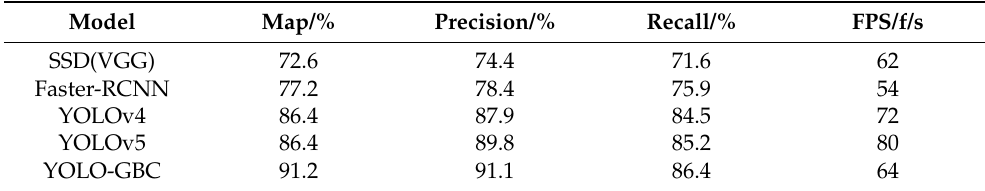
Table 1. Performance comparison results of different algorithms.